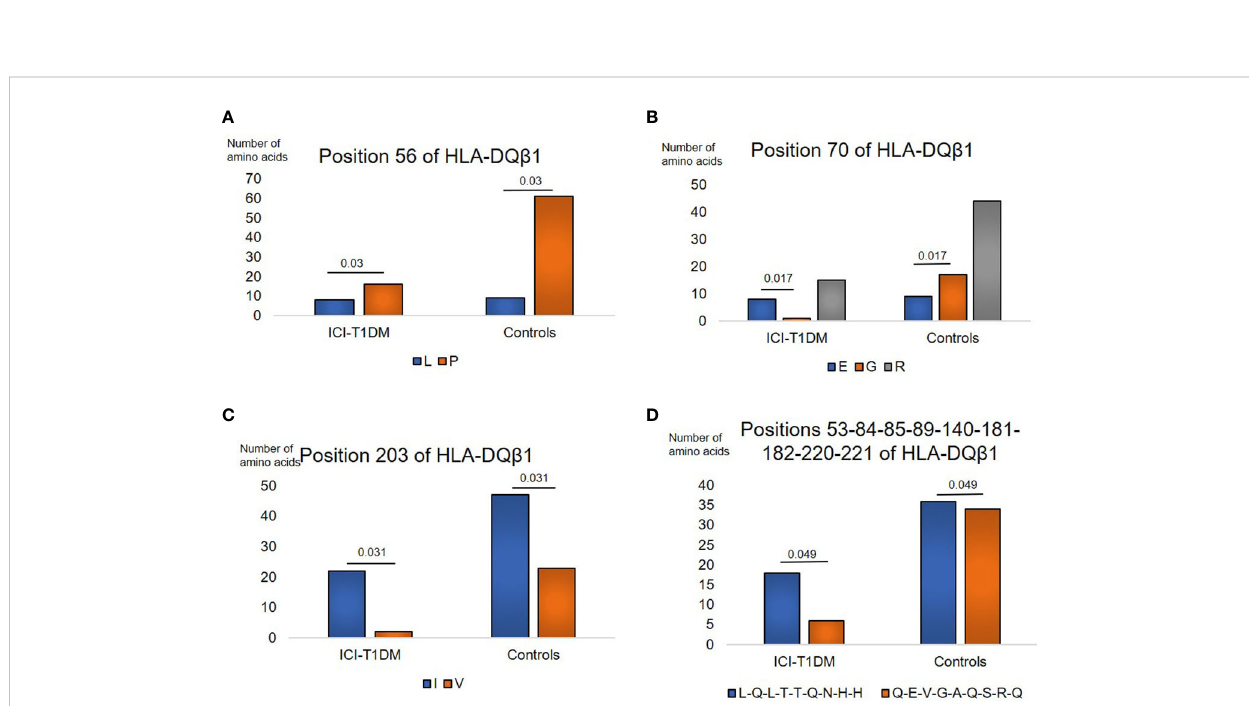
FIGURE 2 Similarly, prevalence of amino acid carriages at residues of HLA-DQB1 allele in patients with ICI-T1DM and ICI-controls (A – D) . Prevalence of amino acid at position 56, L, Leucine vs P, Proline, P=0.03. OR 3.39, 95%CI: 1.13-10.18 (A) , position 70, E, Glutamic acid vs G, Glycine, P=0.017. OR 15.11, 95%CI: 1.62-140.58 (B) , position 203, I, Isoleucine vs V, Valine, P=0.031. OR 5.38, 95%CI: 1.16-24.89 (C) , and positions 53-84-85-89-140-181-182- 220-221, L-Q-L-T-T-Q-N-H-H, Leucine-Glutamine-Leucine-Threonine-Threonine-Glutamine-Asparagine-Histidine-Histidine vs Q-E-V-G-A-Q-S- R-Q, Glutamine-Glutamic acid-Valine-Glycine-Alanine-Glutamine-Serine-Arginine-Glutamine, P=0.049. OR 2.83, 95%CI: 1.01-7.98 (D) are shown. After Bonferroni correction for all signi fi cant amino acid polymorphisms among HLA-DQB1 alleles, no amino acid polymorphisms were signi fi cantly